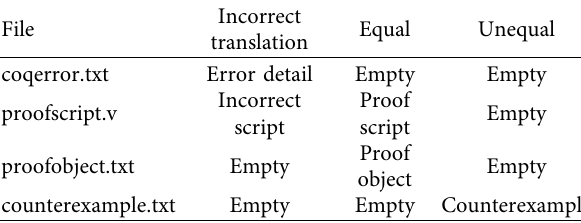
Table 3: Content of files after CoCEC